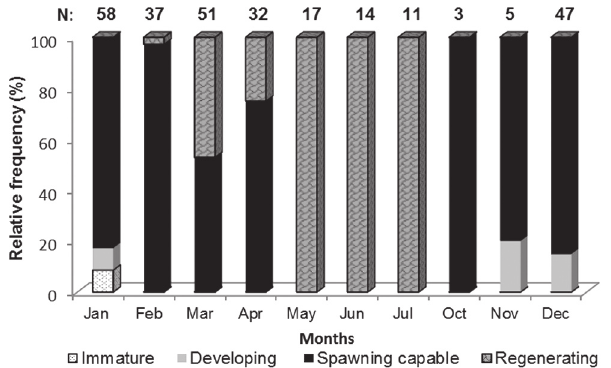
Fig. 2. Monthly relative frequency (%) of gonad phases for females of Anchoa marinii.